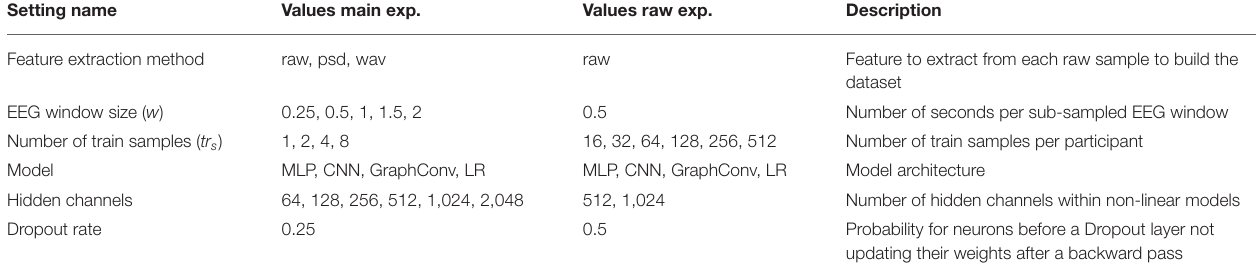
TABLE 2 | Configuration for each experimental phase. Setting name